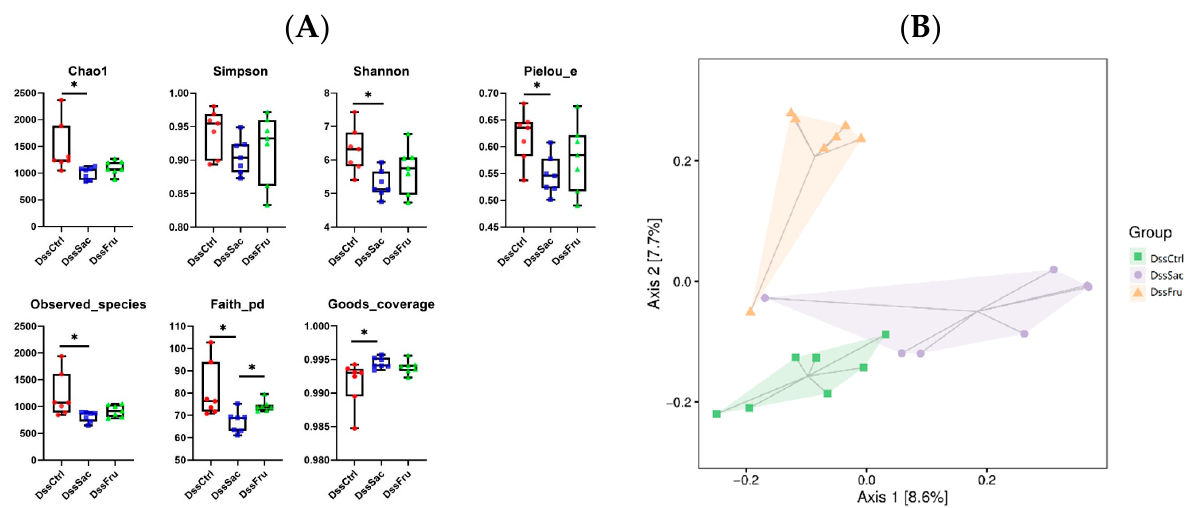
Figure 3. Effects of sucrose and fructose on the overall structure of gut bacteria within different conditions of rats. ( A ) α -diversity analysis; ( B ) PCoA score plot of colon contents based on Jaccards. n = 7. Data represent the following: means ± SEM, * p < 0.05.